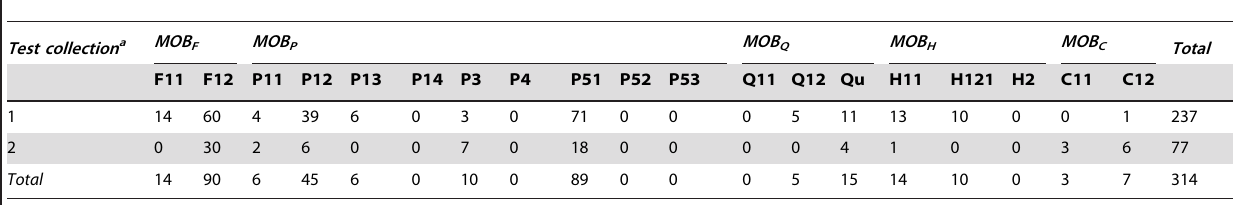
Table 3. Relaxases found in two test collections.